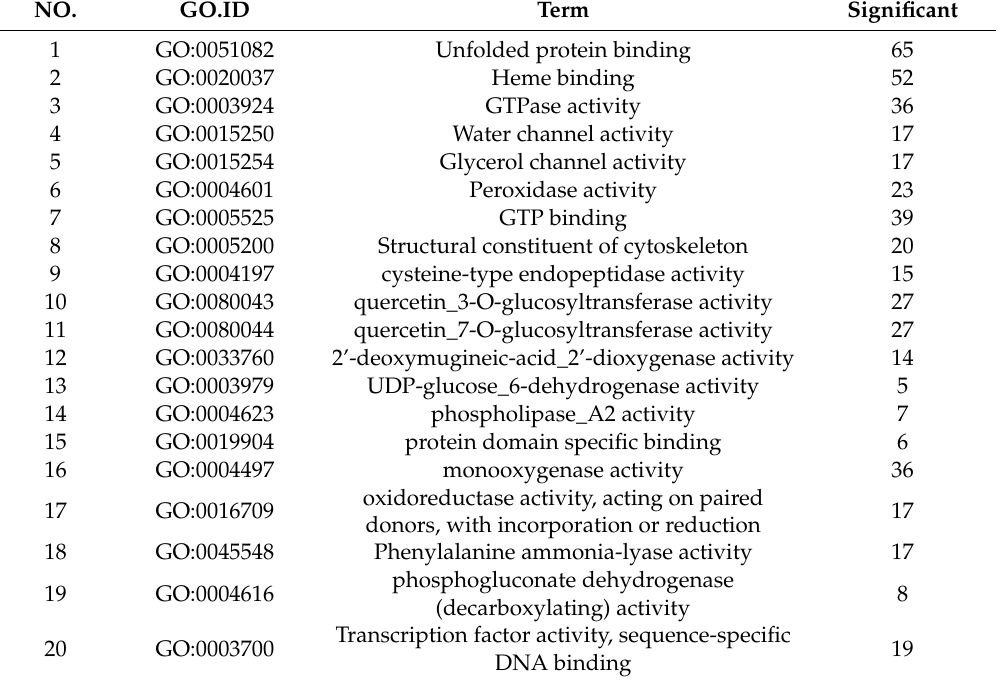
Table 4. GO analysis of DEGs significantly annotated in the molecular function